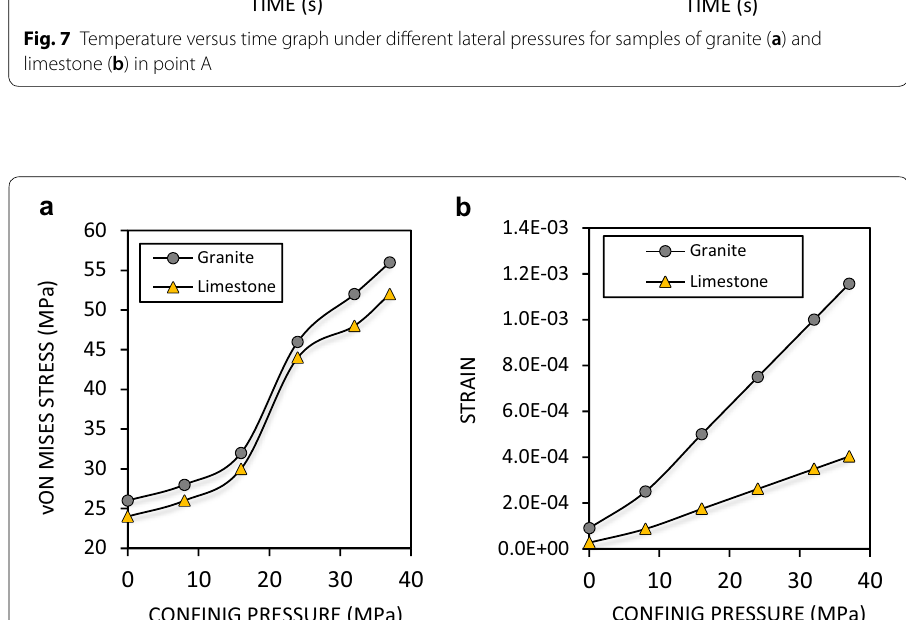
Fig. 8 a Laser-induced stress and b strain diagram under different lateral pressures for samples of granite and limestone in point